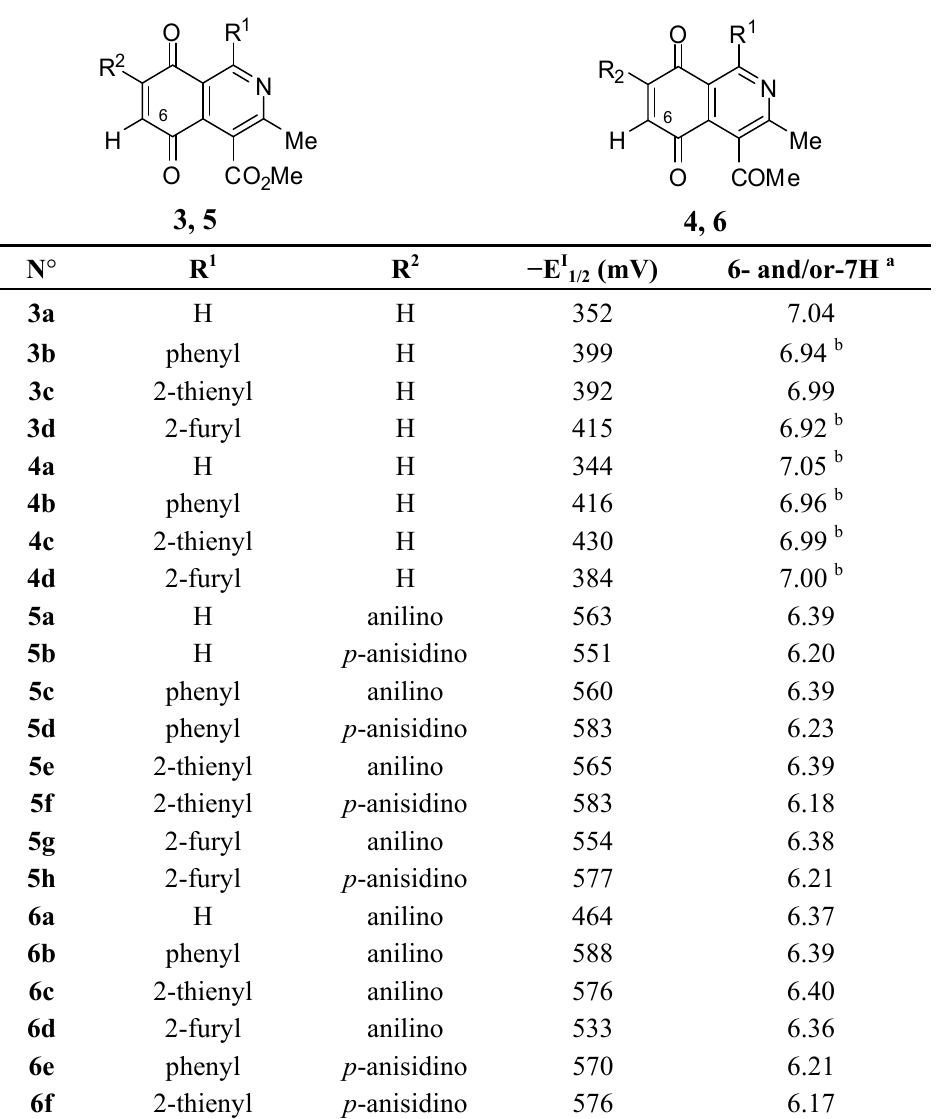
Table 3. Half-wave potentials E I